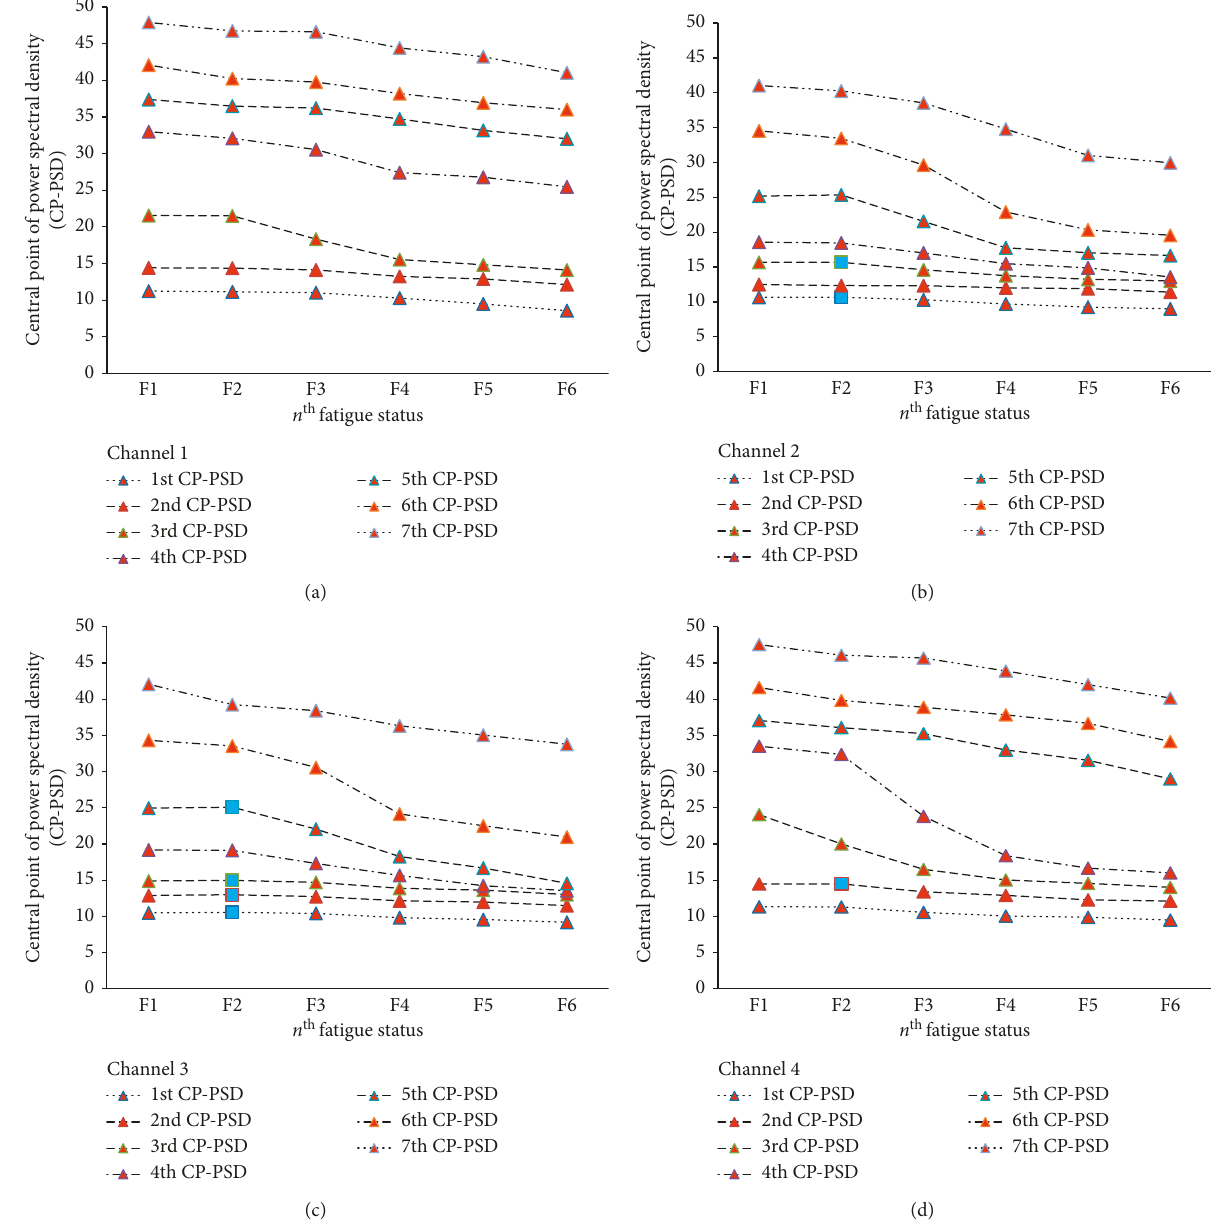
Figure 19: Line graphs showing the position of 7 central points of beams with 4 fatigue